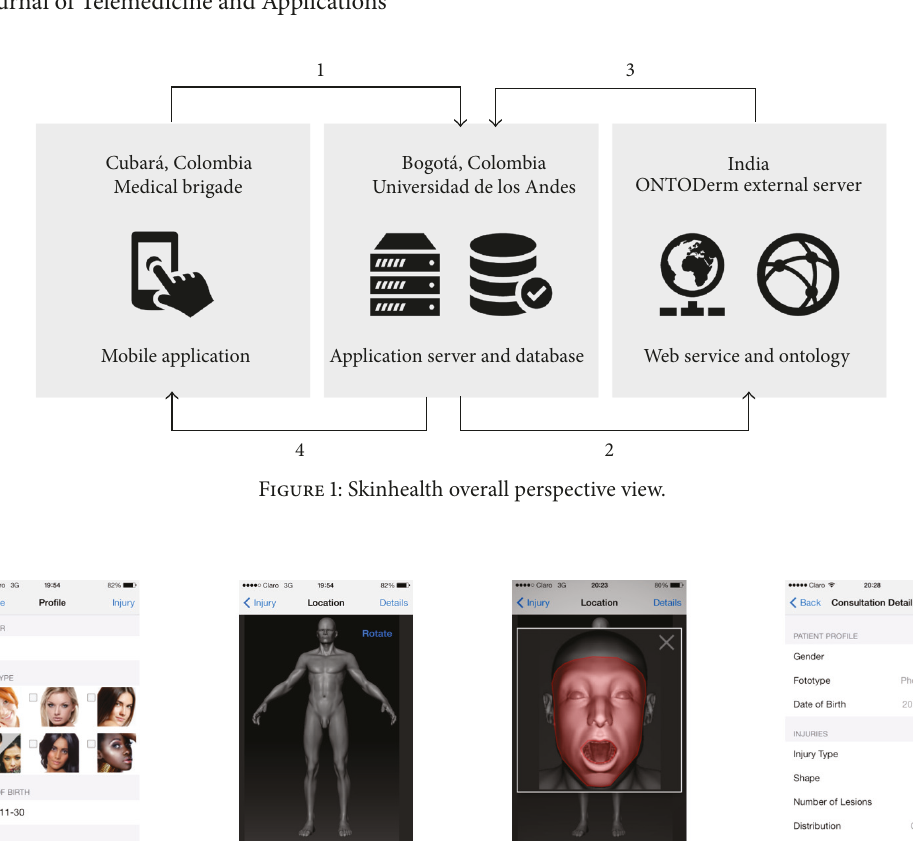
Figure 2: Screenshots of the mobile